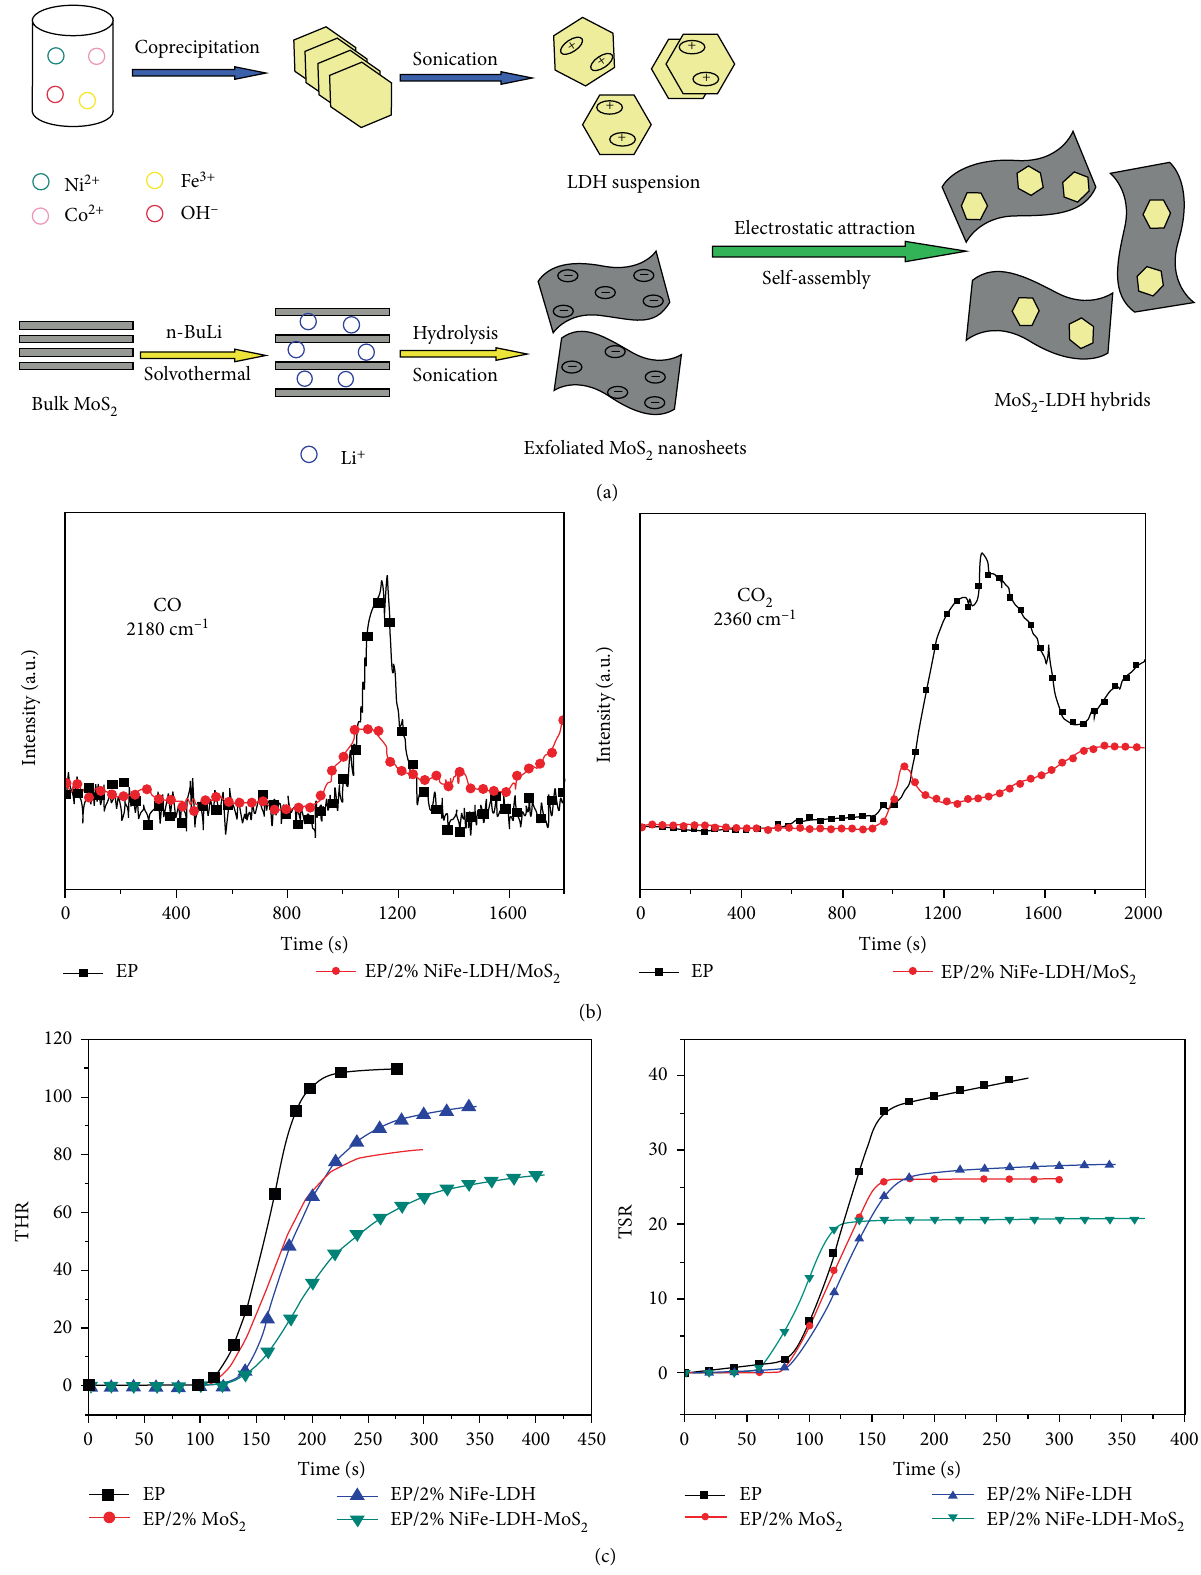
Figure 3: (a) Illustration of the preparation of MoS pyrolysis products of EP and EP/2% NiFe-LDH-MoS